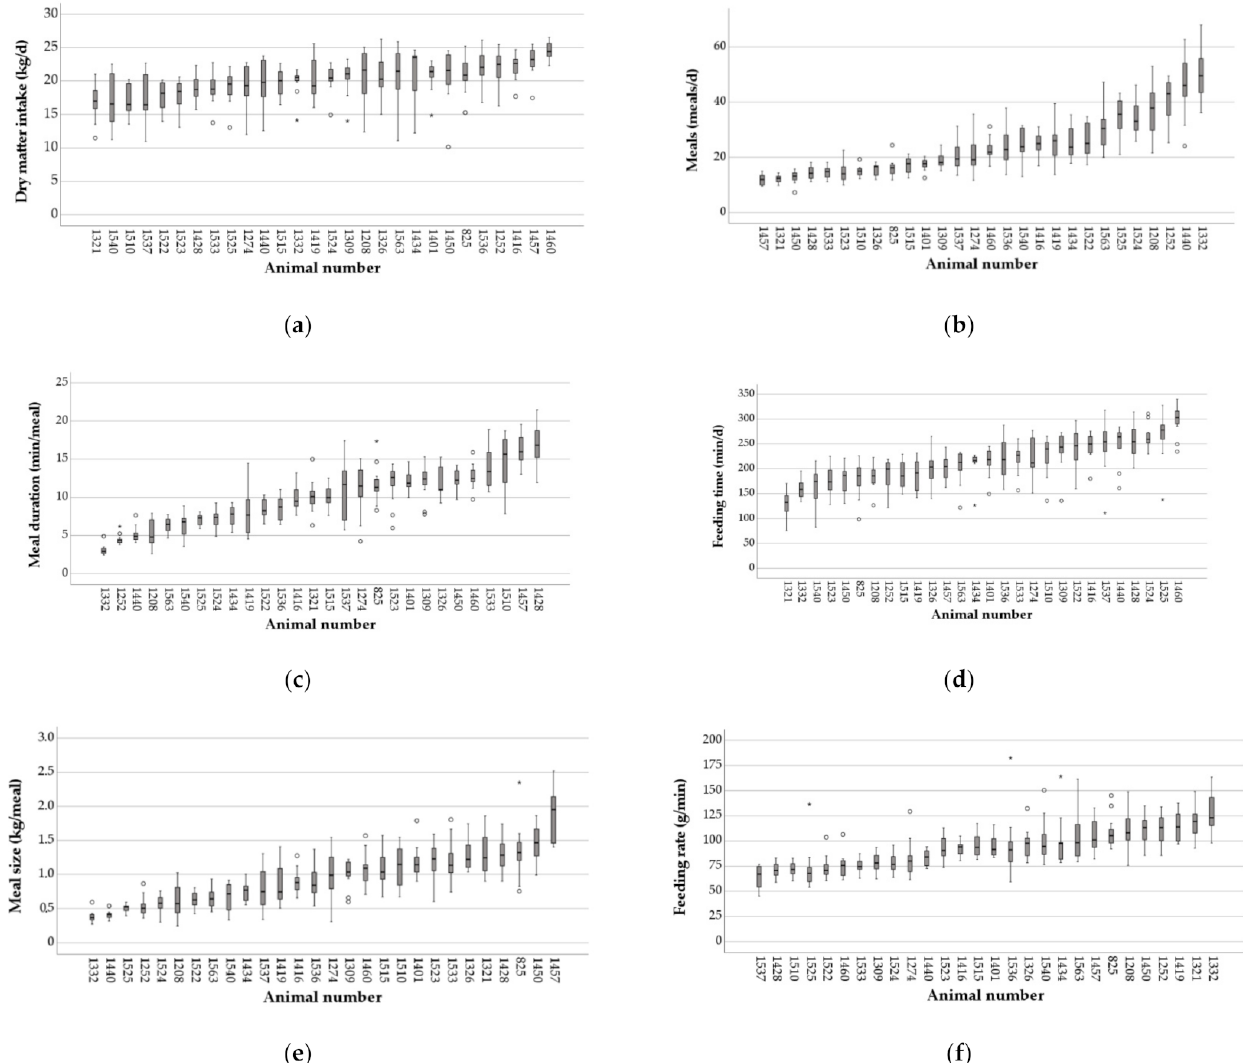
Figure 3. Dry matter intake (kg/day) ( a ), meal frequency (meals/d) ( b ), meal duration (min/meal) ( c ), feeding time (min/d) ( d ), meal size (kg/meal) ( e ) and feeding rate (g/min) ( f ), measured for individual animals (n = 28) between week 2 and 15 postpartum (p.p.). In each subfigure, the boxplots highlight, respectively, the median and upper and lower quartiles of each week. Small circles = outliers (1.5 × interquartile range (IQR)); asterisks = extreme values (3 × IQR). When comparing mean and CV values of intake behavior parameters of cows with mean low, medium and high DMI, no significant differences could be detected between the quartiles (Table